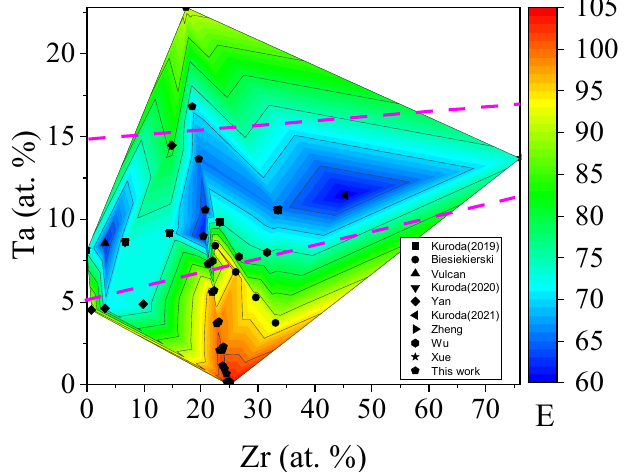
Figure 8. Variation tendency of the elastic modulus of TiZrTa series alloys with contents of Zr and Ta.